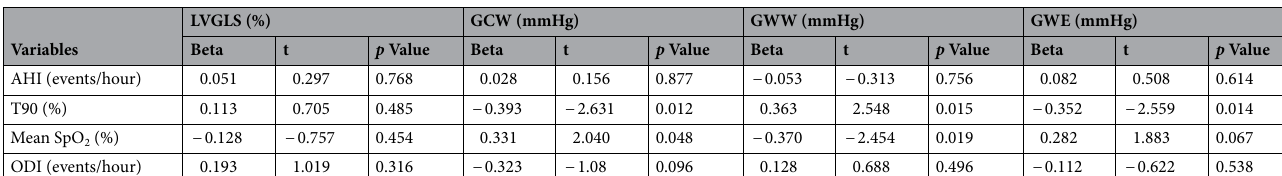
Table 2. Multivariate linear regression analysis* for LVGLS and myocardial work according to AHI and hypoxemia indices (T90, mean SpO 2 , and ODI). *Adjusted by age, sex, body mass index, history of hypertension, and smoking. AHI apnea/hypopnea index, LVGLS left ventricular global longitudinal strain, GCW global constructive work, GWE global work efficiency and GWW global wasted work, Mean SpO 2 mean oxygen saturation, ODI oxygen desaturation index, T90 percentage of sleep time below 90% oxygen